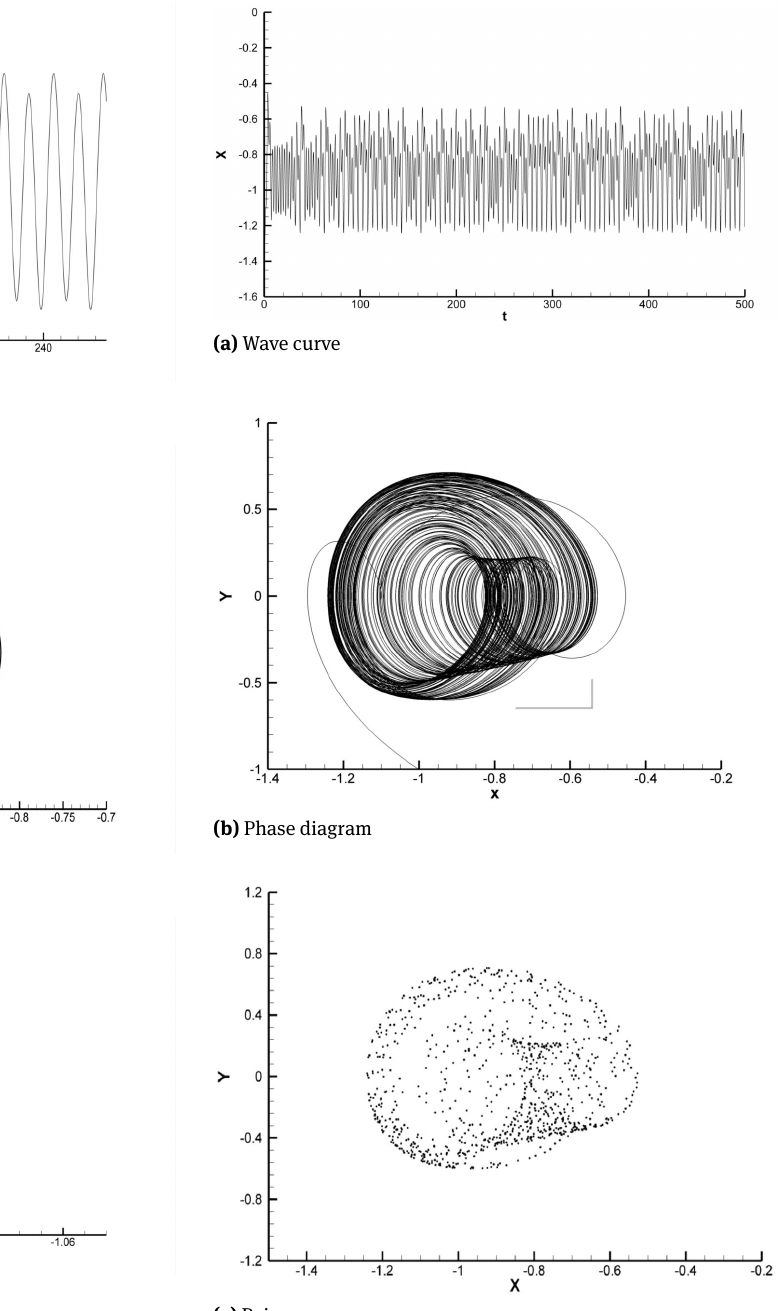
Figure 5: Complex periodic behavior of non-linear system ( r = 0.45, ω = 2.2, k = 0.5, x (0) = −1.0 , ˙ x (0) = −1.0 ) Figure 6: